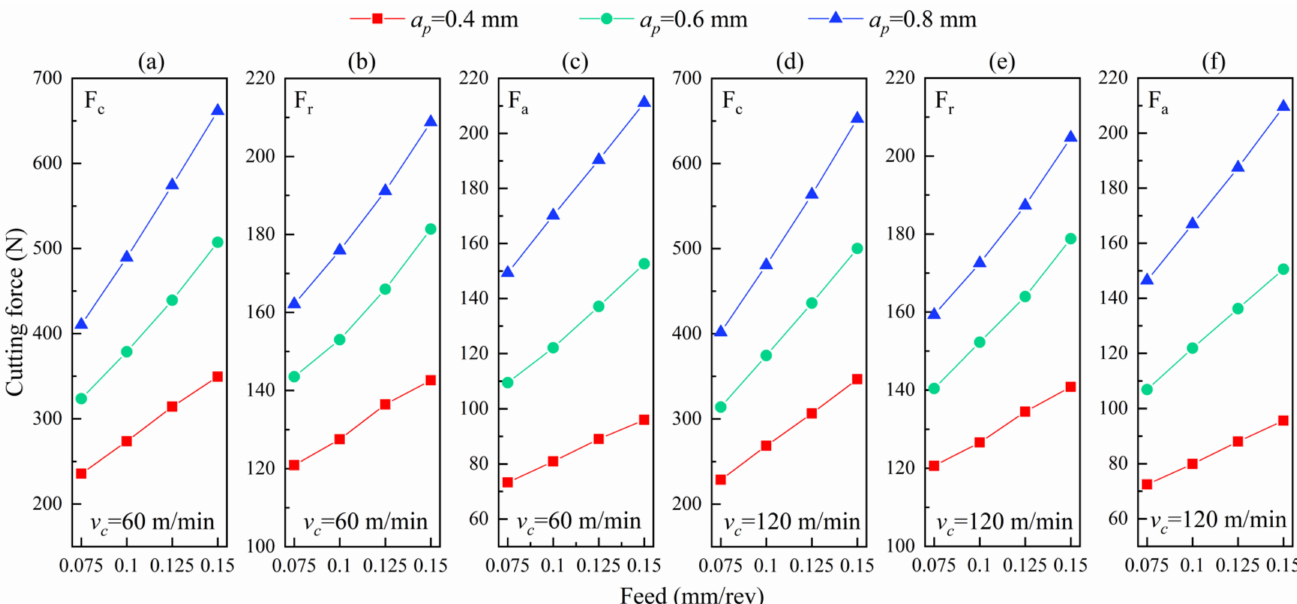
Figure 6. The trends of the cutting force components with feed at each cutting speed. ( a ) The circumferential force (60 m/min), ( b ) the radial force (60 m/min), and ( c ) the axial force (60 m/min). ( d ) The circumferential force (120 m/min), ( e ) the radial force (120 m/min), and ( f ) the axial force (120